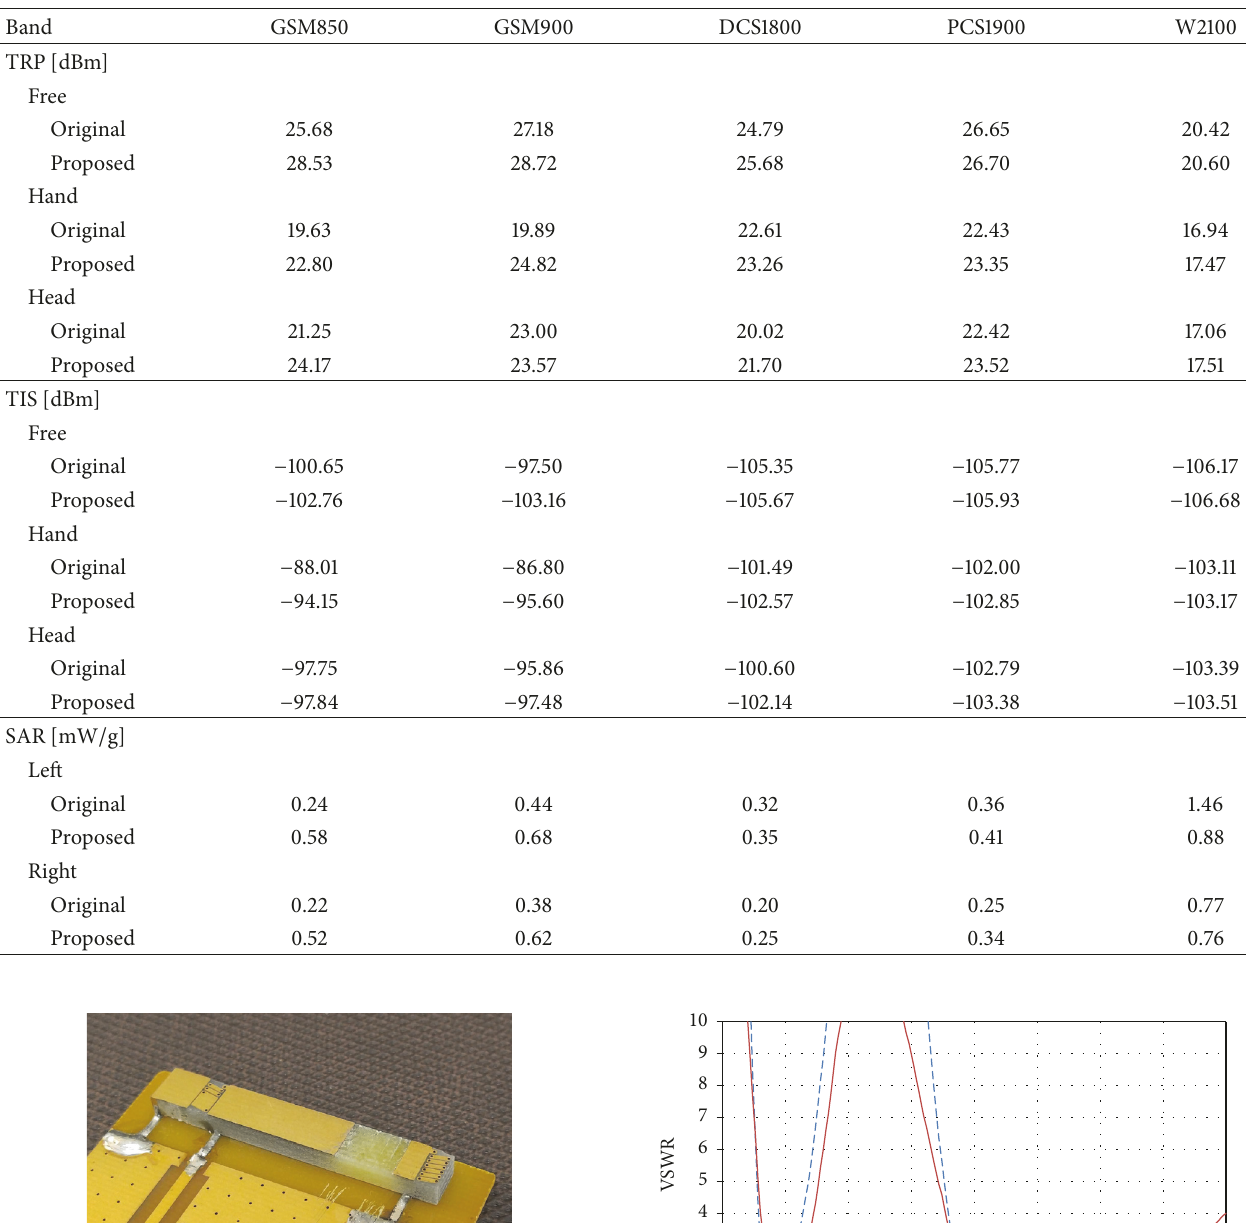
Table 1: Measured TRP, TIS, and SAR values of the proposed antenna and the original antenna of the device.